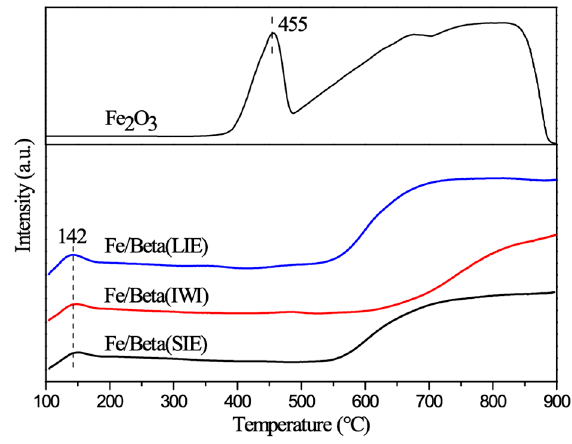
Figure 4. Temperature-programmed reduction with hydrogen (H 2 -TPR) profiles of Fe 2 O 3 and Fe/Beta catalysts.